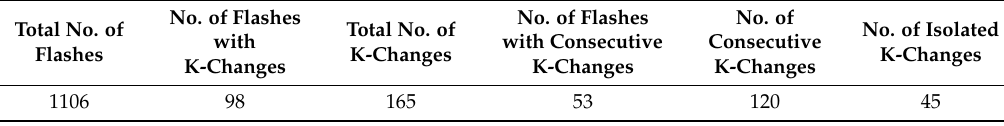
Table 1. Summary of selected K-changes for the